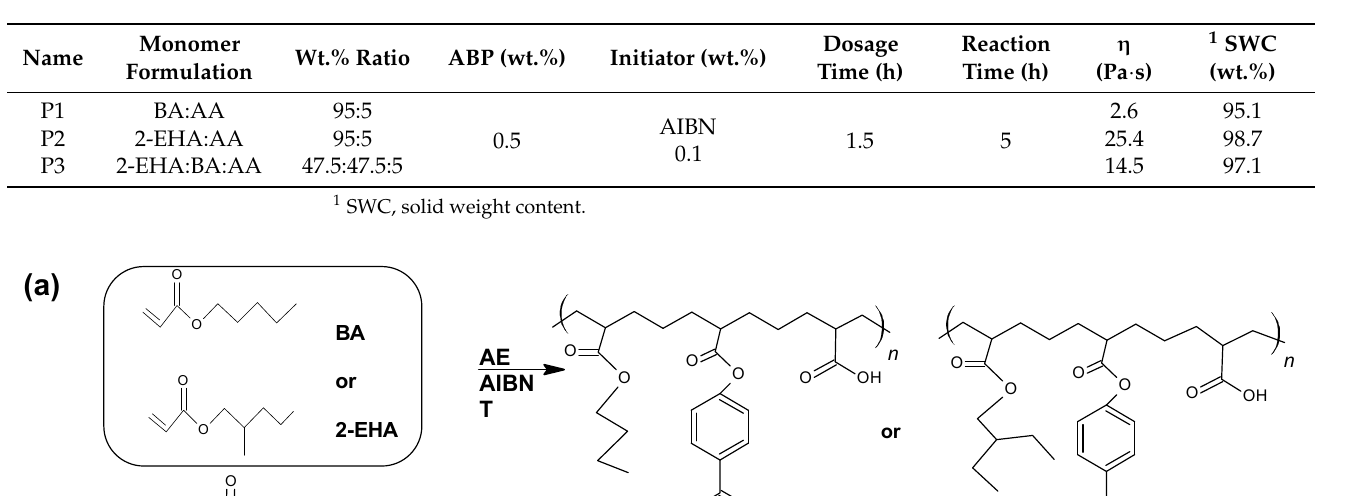
Table 2. Composition of synthesized pressure-sensitive adhesives and reaction conditions. Monomers: